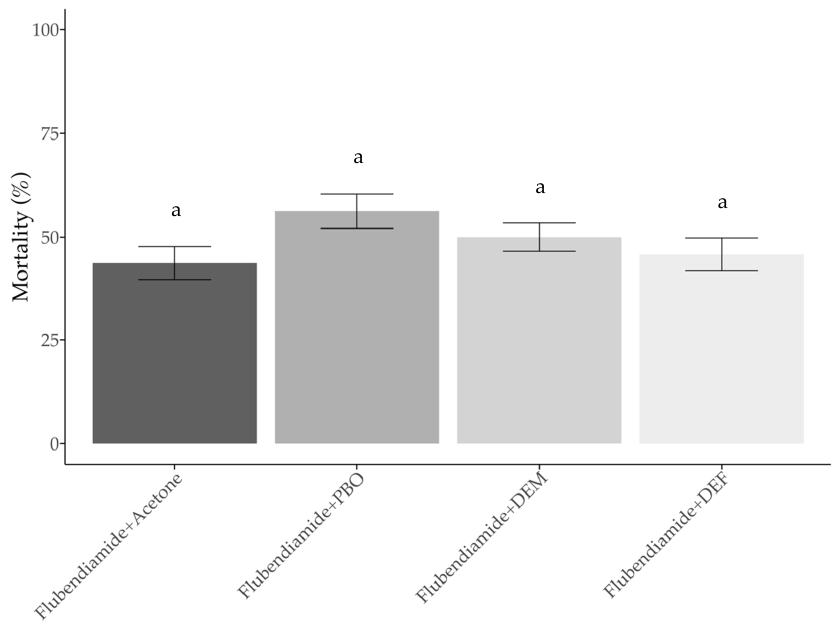
Figure 4 . Effect of synergists (PBO, DEM and DEF) on H. armigera (third-instar larvae) mortality to flubendiamide. Bars fallowed by the same letter do not differ from the treatment control (flubendiamide + acetone) according to the Tukey’s test ( p > 0.05).